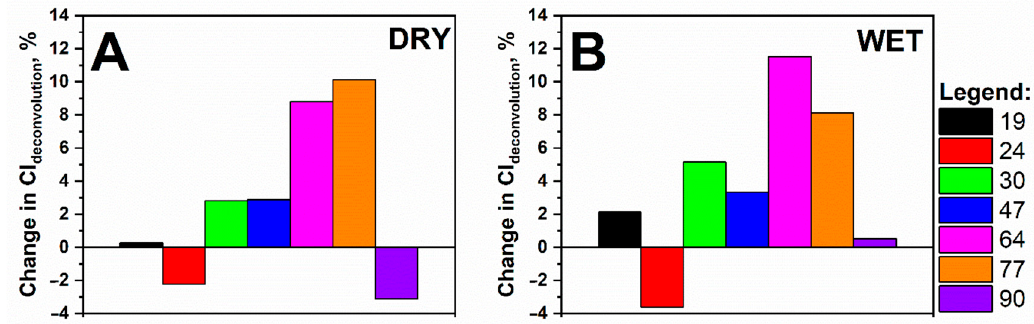
Figure 7. Changes in crystallinity indexes, observed for the cellulose/lignin samples, under different ageing conditions: ( A ) dry atmosphere and ( B ) humid atmosphere.